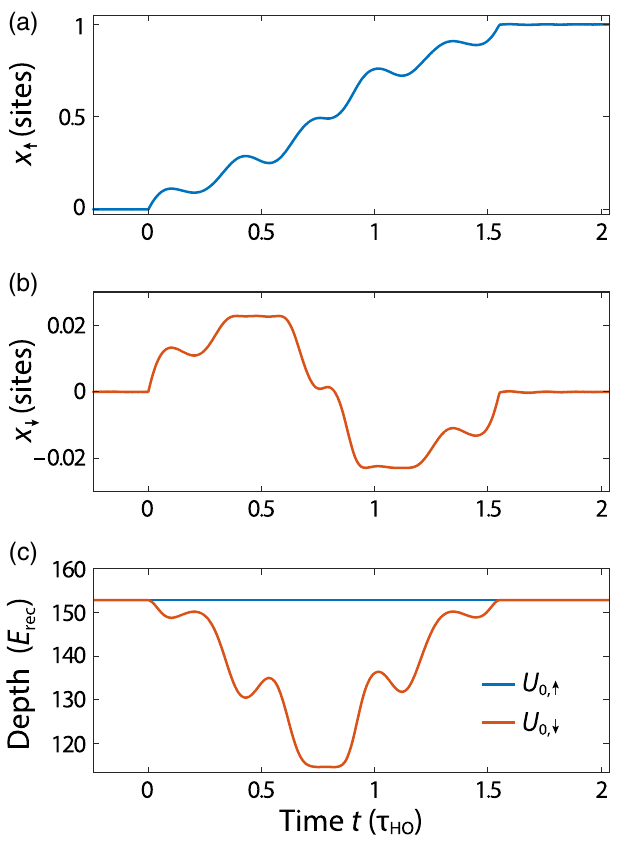
FIG. 4. Cross talk between spin-dependent potentials. Example of transport ramp as in Fig. 1(d) when varying x R ð t Þ without compensating x L ð t Þ ; i.e., x L ð t Þ ¼ x L ð 0 Þ . (a) The position of the spin-up potential only depends on the R -polarized standing wave, x t Þ ¼ x t Þ . The position (b) and depth (c) of the spin-down ↑ ð R ð potential are modulated because of the cross-talk contribution from the moving R -polarized standing wave; see Eq.